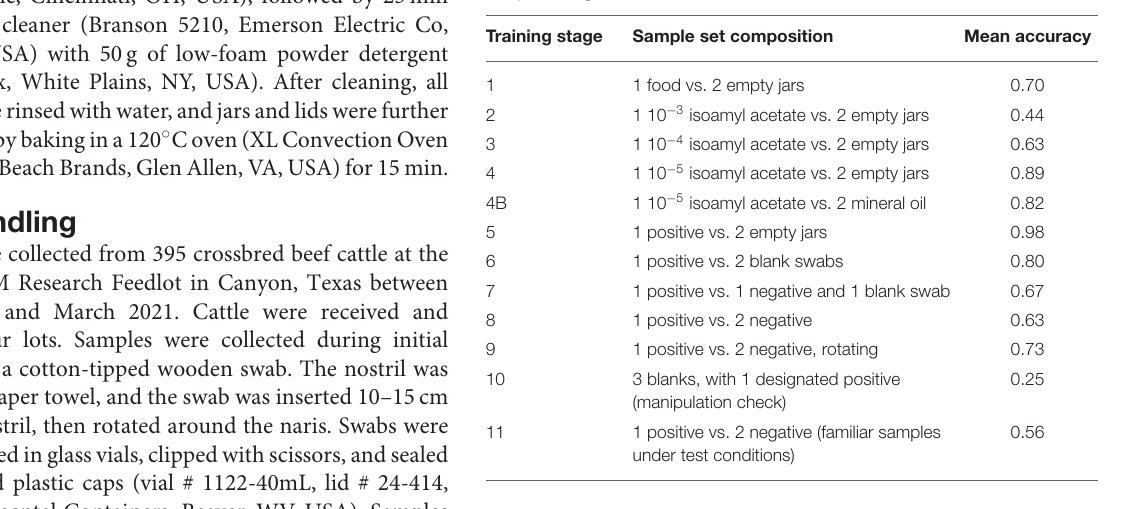
TABLE 1 | The stages of training used to teach the dog to detect specific samples using